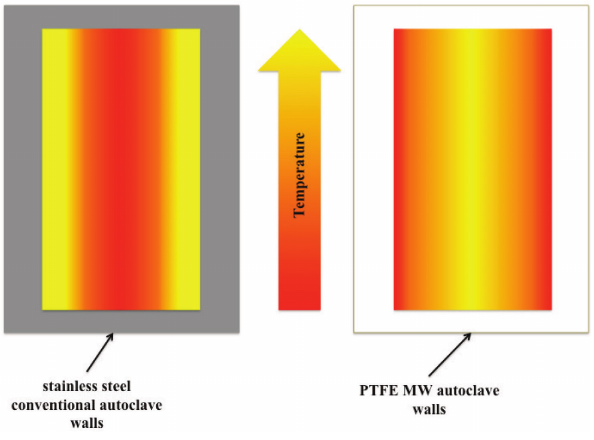
Figure 1. Example of temperature profiles occurring in a reaction mixture exposed to conventional heating ( left , e.g., inside a stainless steel autoclave) and to microwave heating ( right , e.g., inside a microwave transparent polytetrafluoroethylene (PTFE) reaction